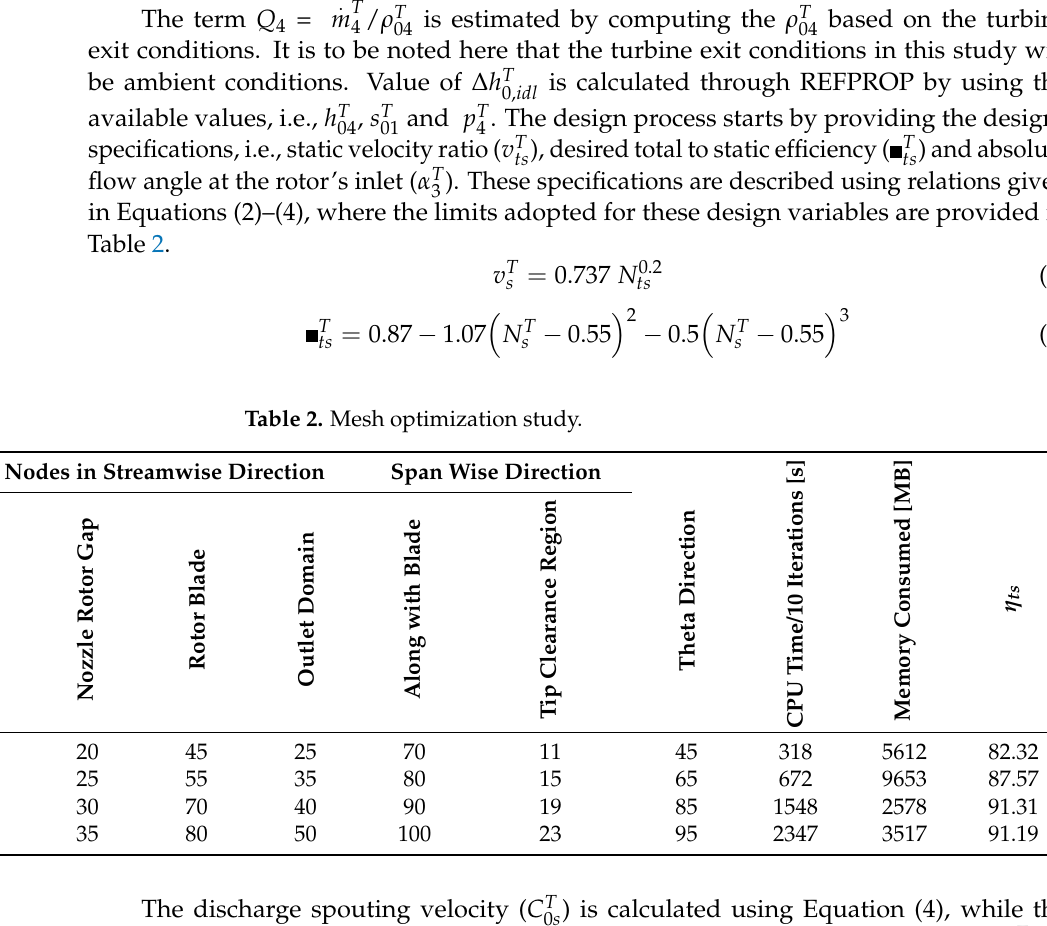
Table 1. Given and required conditions for the design of the Expander system. Items Symbols Values . The mass flow rate of exhaust CO 2 m 50 [kg s − 1 ] Temperate of exhaust gases T o 1 983 [K] Expansion ratio P o 1 3 P 3 The desired value of total to static efficiency NG ts 0.90 . Desired turbine output power W 8 [MW] Rotational speed ω 40,000 [rpm] The term Q 4 =